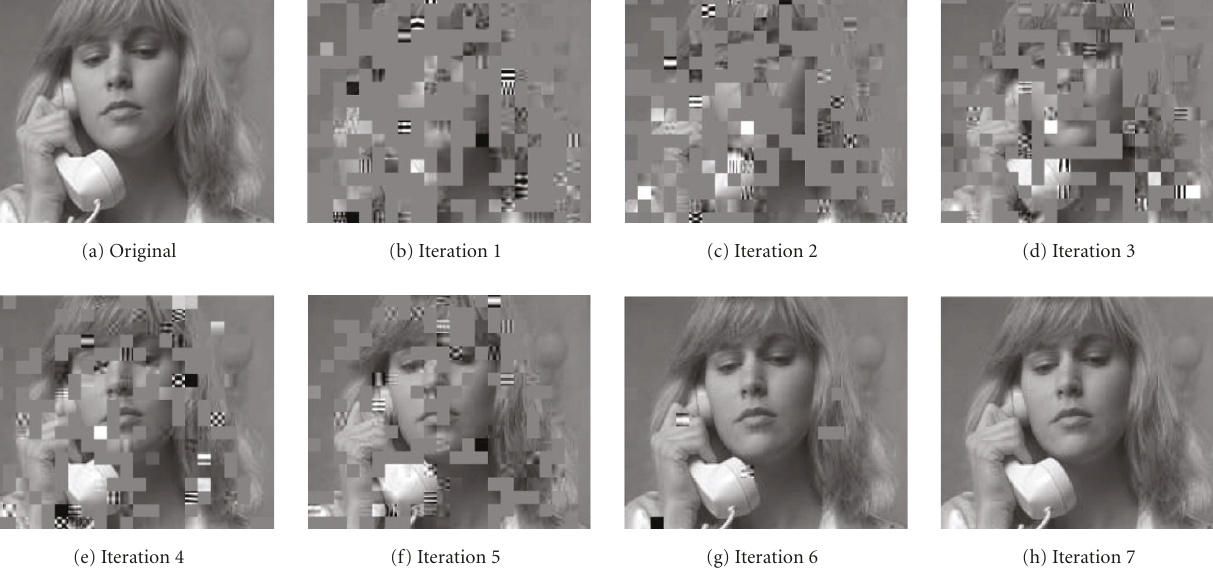
Figure 17: Original and decoded “Suzie” images over Rayleigh fading channel using proposed asymmetric turbo code with an E b /N 0 of 6dB, f d =